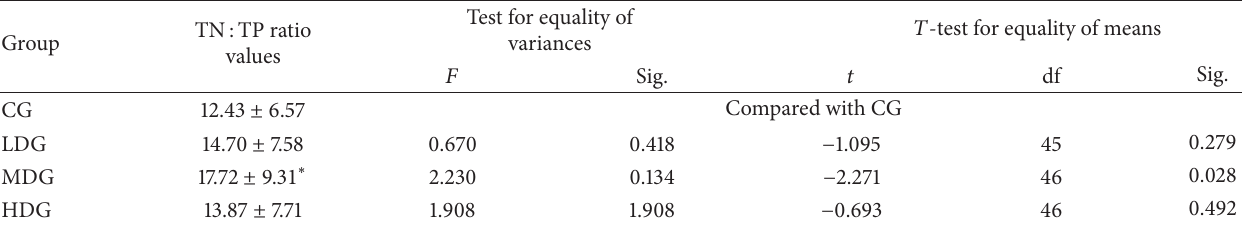
Table 2: N :P ratio values and comparison between CG and treatments for each treatment. Results of TN: TP ratio are performed as mean ± STDEV; means with asterisk “ ∗ ” stand for significant difference ( 𝑇 -test).